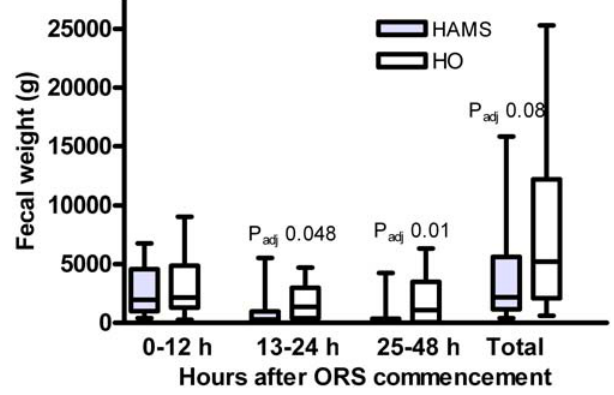
Figure 3. Fecal weight during the time periods 0–12 hours, 13– 24 hours, and 25–48 hours after commencement of ORS and total diarrheal fecal weight. The box and whiskers plots show median and IQR (box) and lowest and highest value (whiskers). Two- tailed adjusted P values (Mann-Whitney) show the significance of differences between HAMS and HO ORS for that particular time period.